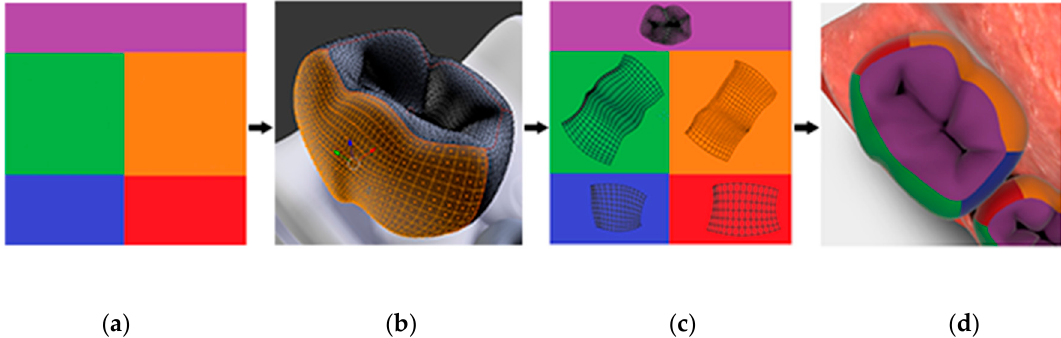
Figure 2. Representation of the UV mapping process for a single tooth: ( a ) Image file UV_T.PNG, pre-colored for convenience with desired subsections; ( b ) The mesh of tooth T being sectioned into surfaces of interest; ( c ) The mesh of tooth T cut and UV mapped within Tooth_T.PNG; ( d ) The rendered appearance of tooth T after completion of UV mapping.